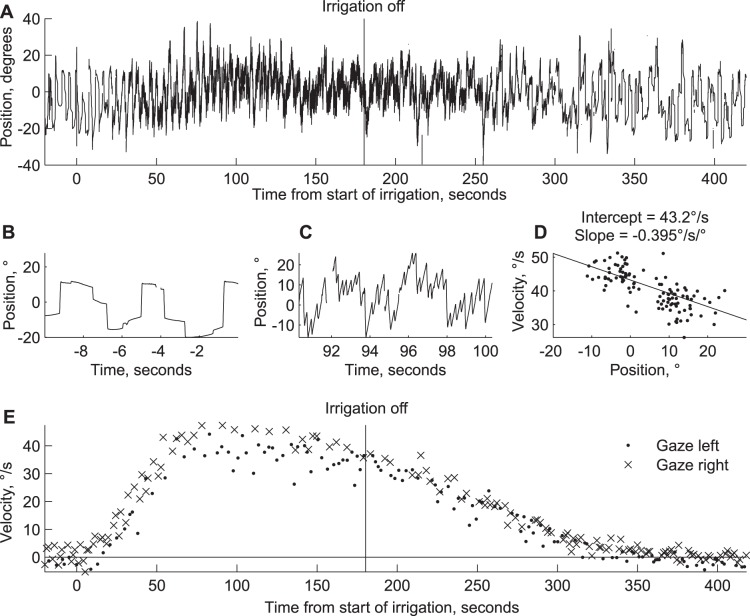
Example data.A. Horizontal eye position is shown for an experiment with bilateral, bithermal caloric stimulation. The subject looked into the direction of a flashing laser spot that first shifted between 20° left and right positions (time <120 s), and then the target shifted to targets at ±20°, ±10°, and 0° for the remainder of the experiment. B. Position traces before stimulation began, so little nystagmus is observed. C. Position traces from near the time of maximum velocity. D. Velocity is plotted versus position for 30 seconds of data selected at the time of maximum nystagmus. Each point is an individual slow phase. The best fit line and fitted parameters are also shown. E. The velocity of individual slow phases is shown, with different symbols used when subjects were looking left and right of straight ahead. For clarity, only 1 in 10 slow phases are shown.